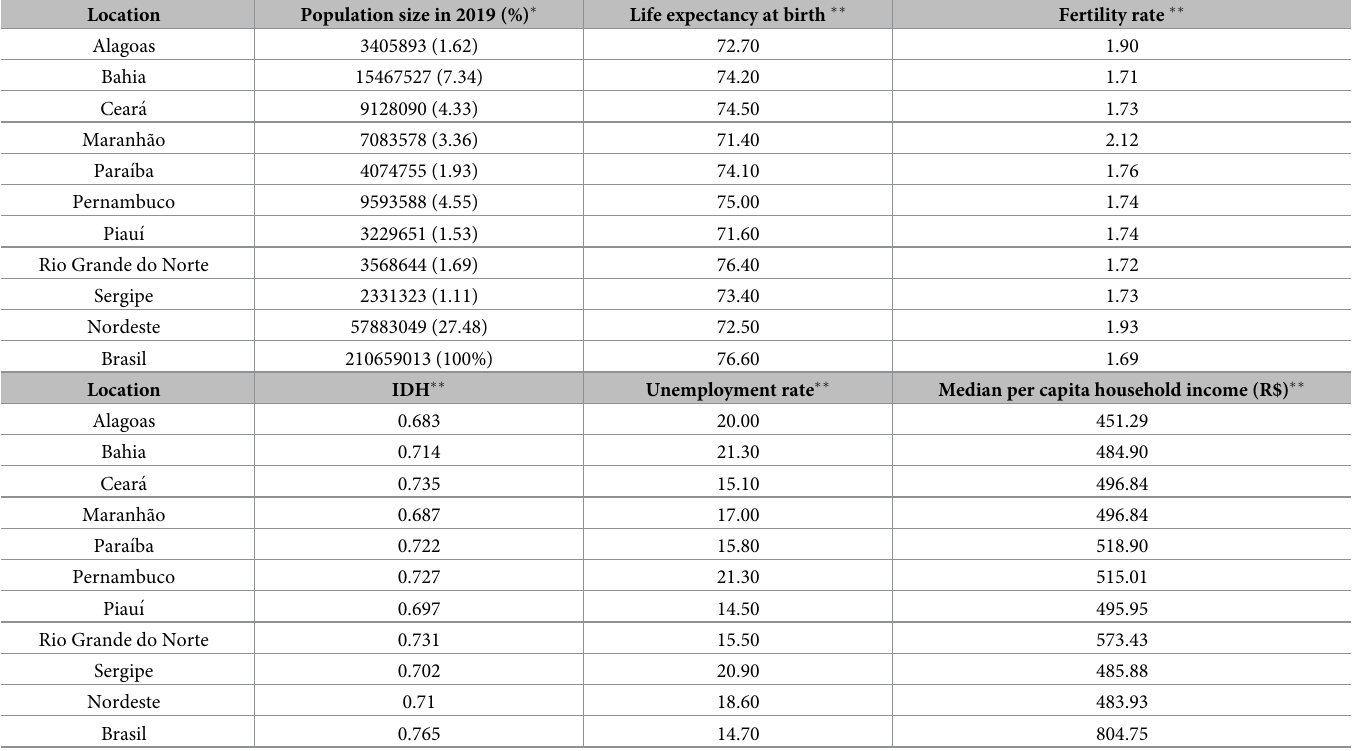
Table 1. Sociodemographic characteristics of the states in the Northeast region of